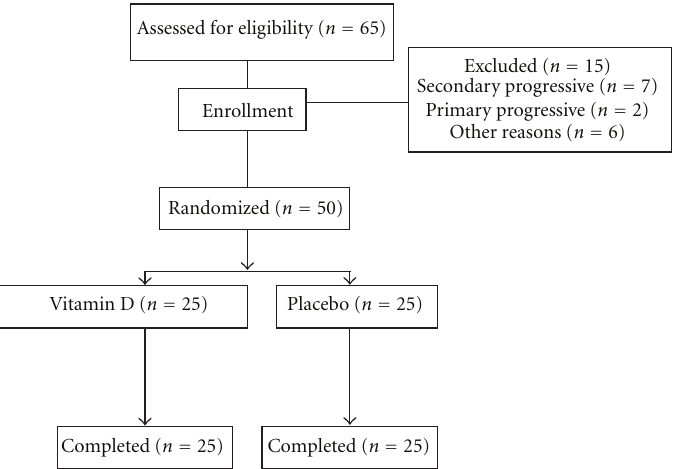
Figure 1: Design of the trial to compare oral vitamin D (0.5 µ g/day) versus placebo in patients with relapsing-remitting multiple sclerosis.